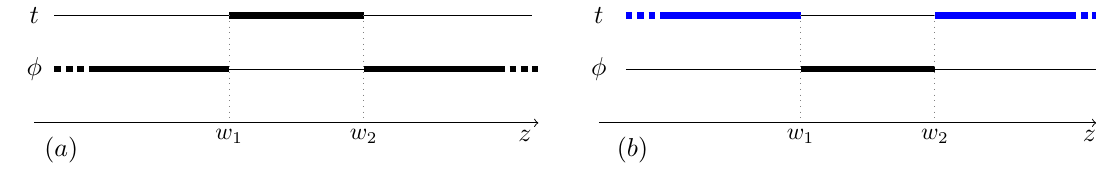
Figure 3 . ( a ) rod diagram for the Schwarzschild black hole. The finite timelike rod defines the black hole horizon (a sphere S 2 , from the fibration of the φ parallel circles over the segment w 1 < z < w 2 ). φ gives ( b ) : rod diagram of the expanding bubble of nothing. The semi-infinite Exchanging t ↔ timelike rods represent the bubble acceleration horizons (two of them, each with topology R 2 ). Here and in the following figures, acceleration horizons are pictured in